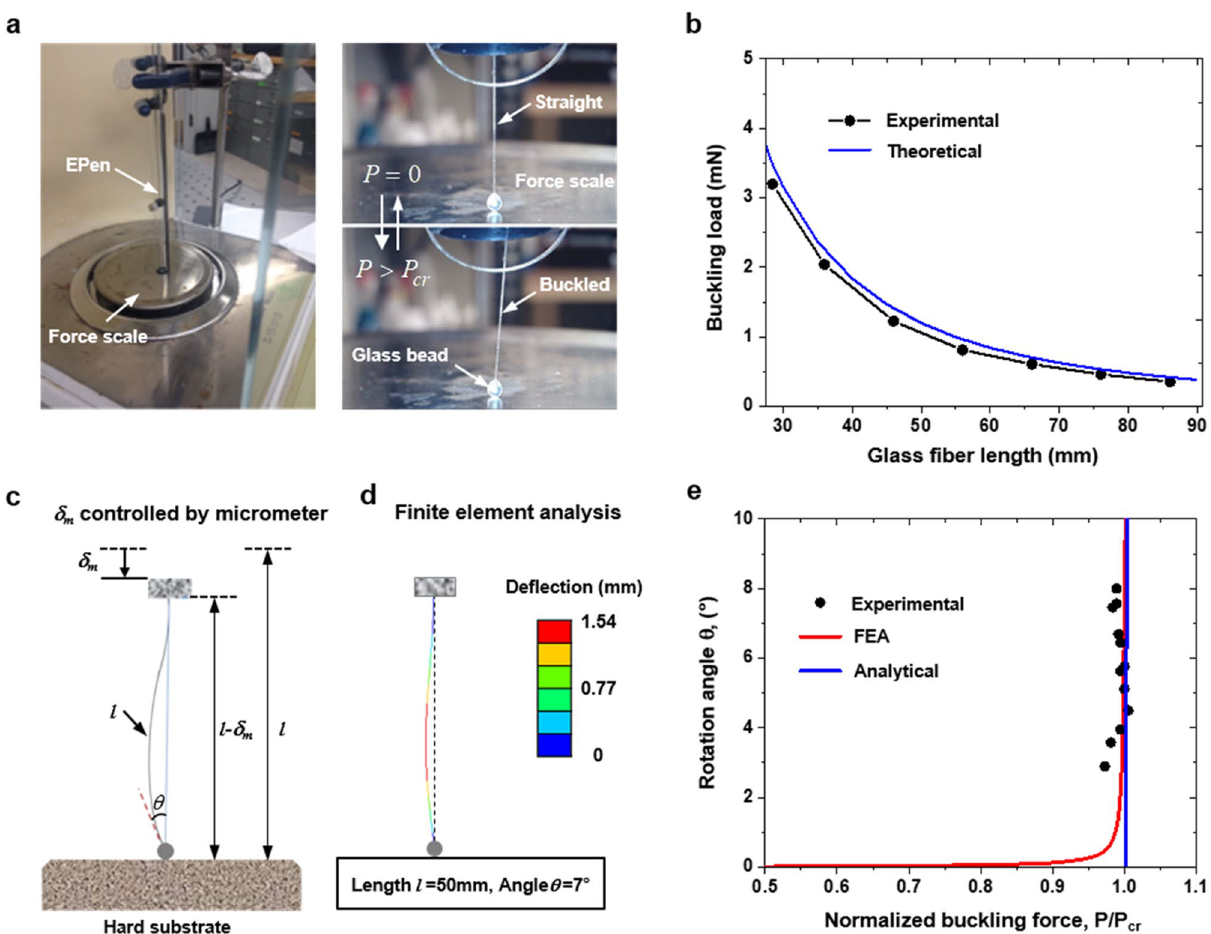
Figure 3. Calibration and error analysis. ( a ) The measurement of critical buckling force by buckling the glass fiber against a force scale. ( b ) The relation between the critical buckling force and glass fiber length is shown. Experimental values are slightly lower due to unavoidable imperfections in the fiber and misalignment between the fiber and the sphere. ( c ) Schematic of the buckled glass fiber on a hard substrate by a displacement control via a micrometer. ( d ) The deflection contours of a slender glass fiber with the initial length of 50 mm and buckling angle 7°. ( e ) Measurements of rotation angle as a function of applied force obtained from the experiment (black dots) are quantitatively consistent with analytical calculations of the mechanics (analytical; blue line) and finite element analysis (FEA, red